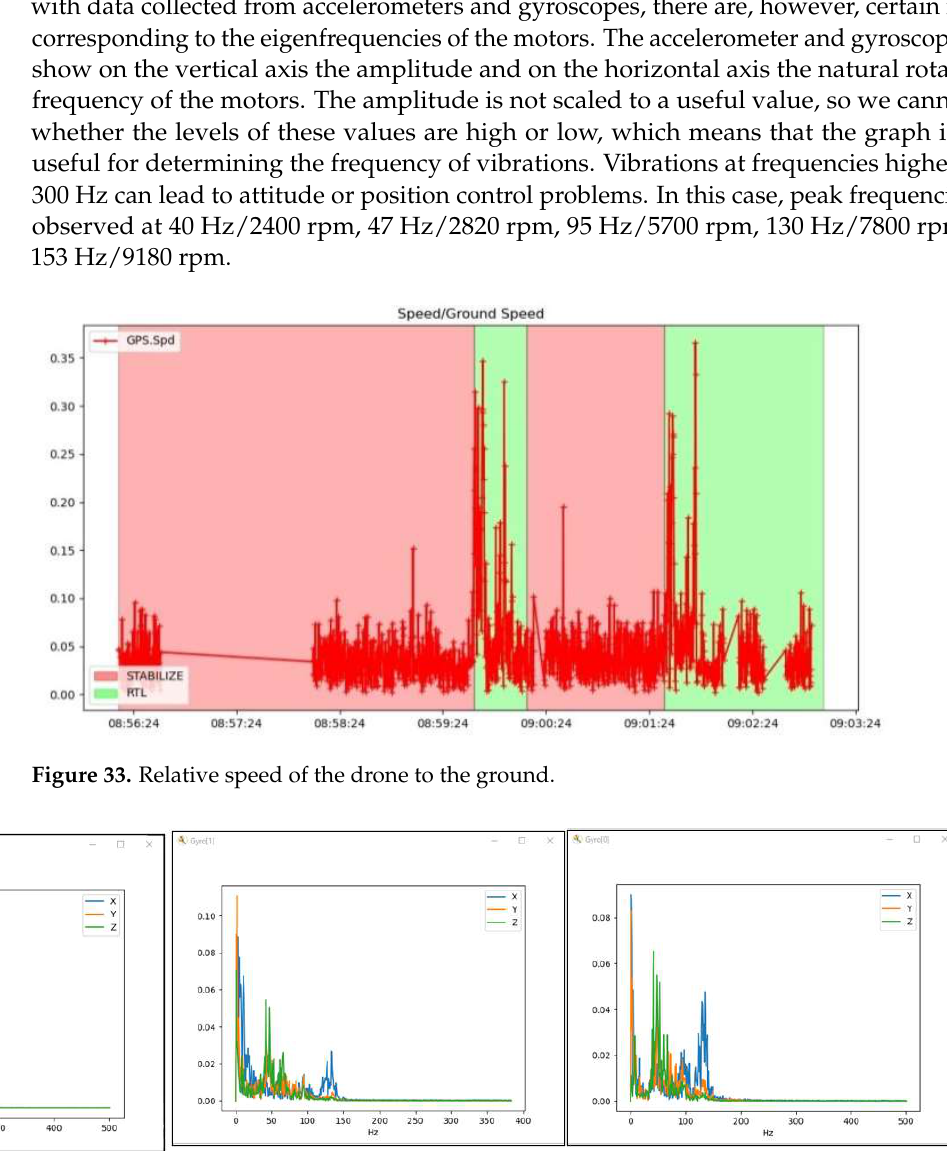
Figure 34. Vibration frequencies induced by motors